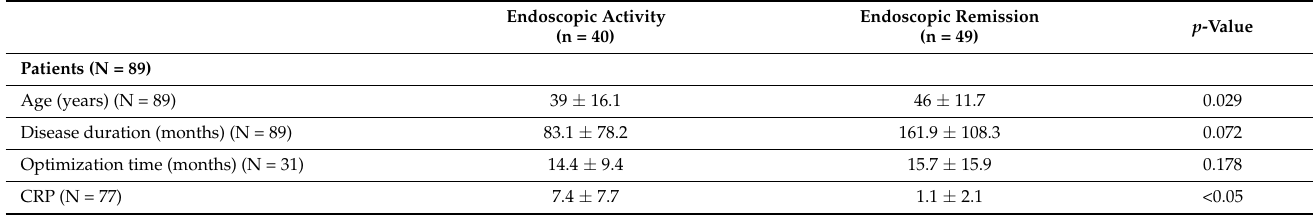
Table 2. Baseline characteristics of patient population analyzed in subgroups regarding endoscopic disease activity in cd. X 2 chi-square; t